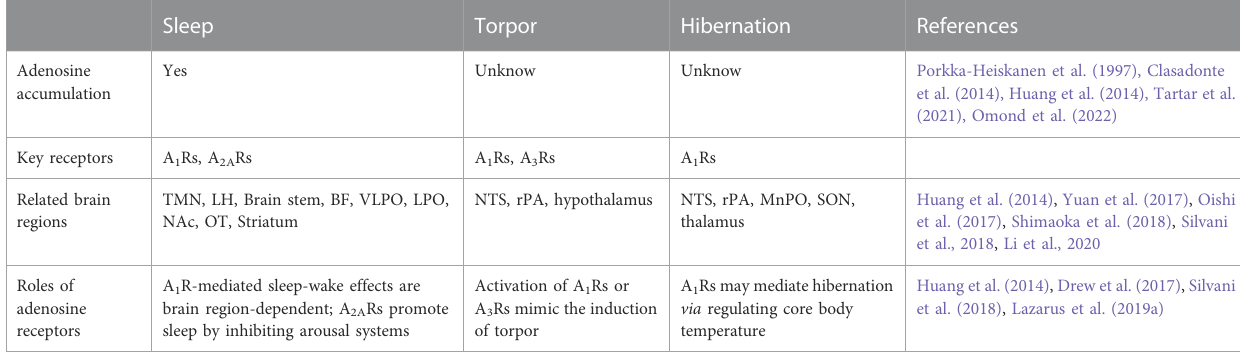
TABLE 2 Roles of adenosine receptors in sleep, torpor, and